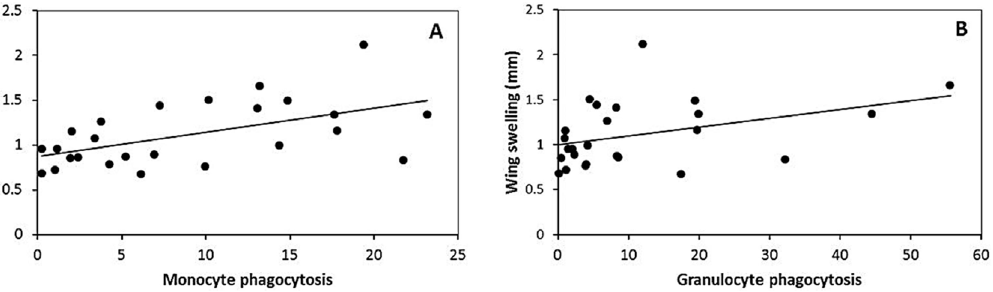
Figure 2. Regression lines between phagocytosis and wing swelling response to PHA injection of 14 days-old nestlings spotless starling. (A) monocyte phagocytosis and (B) granulocyte phagocytosis.